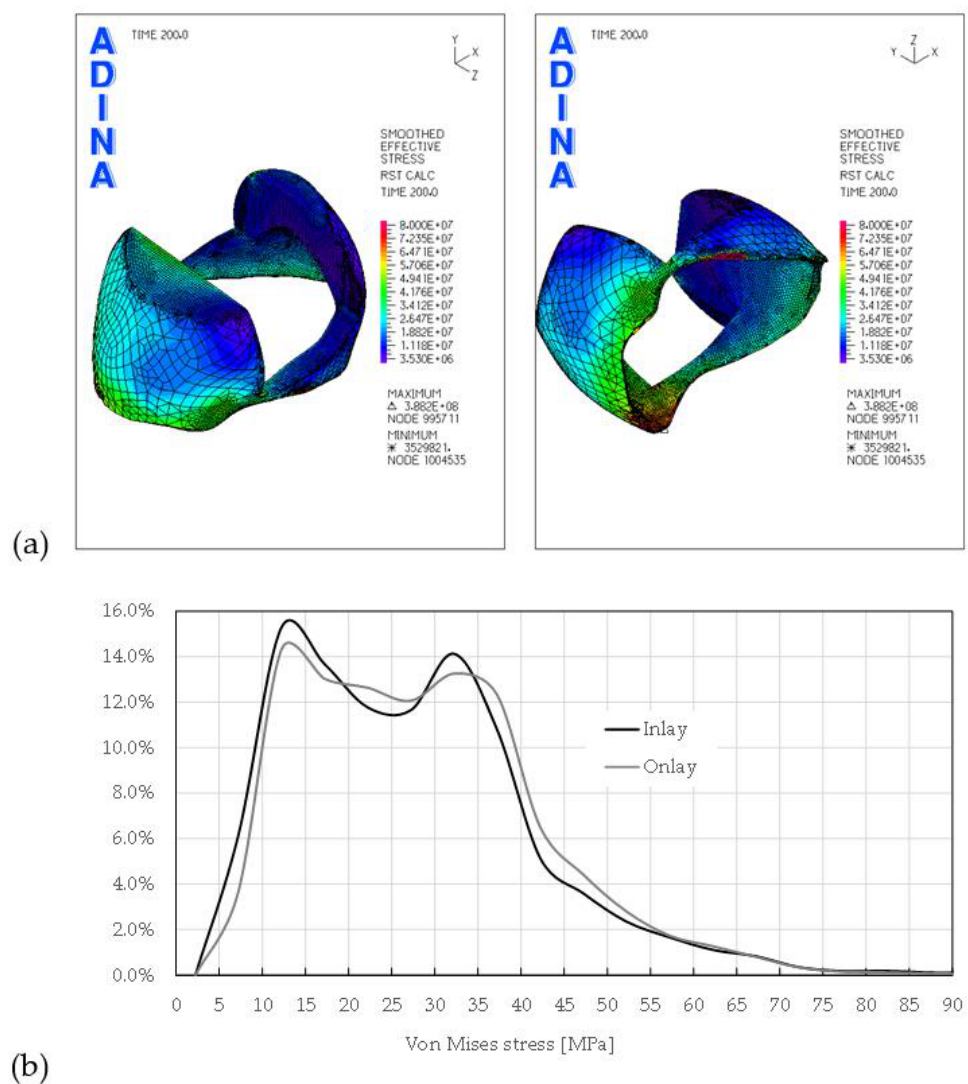
Figure 6. Smoothed stress distributions on the enamel. ( a ) Onlay (left side lateral perspective view) and onlay (right side bottom perspective view). ( b ) Histograms of the distributions for both models. Table 8. Statistical description of the stress distributions for the enamel restorations.